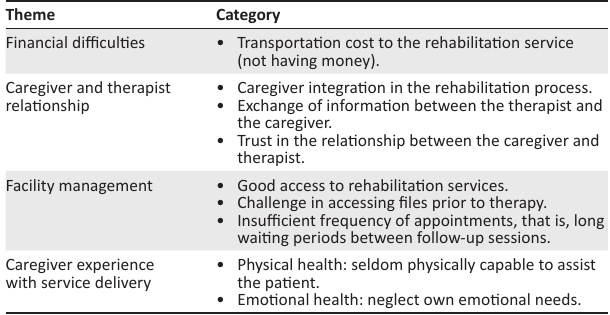
TABLE 2: Emerging themes and categories.